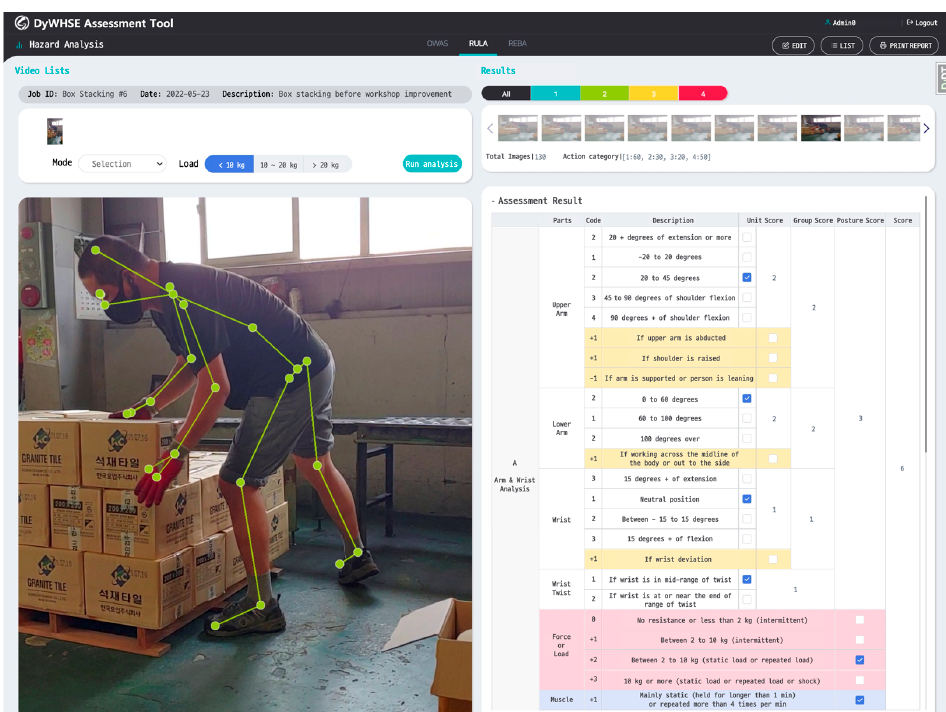
Figure 14. DyWHSE assessment